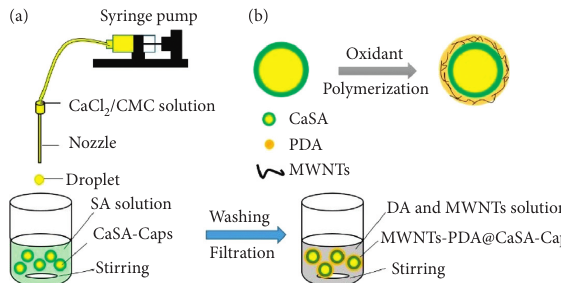
Figure 1: (a) Preparation of mm-MWNTs-PDA@CaSA-Caps. (b) Structure of mm-MWNTs-PDA@CaSA-Caps.